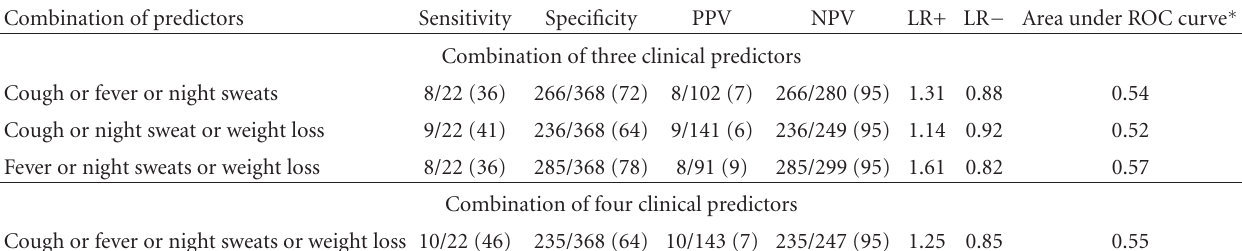
Table 2: Performance of di ff erent algorithms in screening TB for 390 HIV-infected patients having sputum smear negative to AFB. Combination of predictors